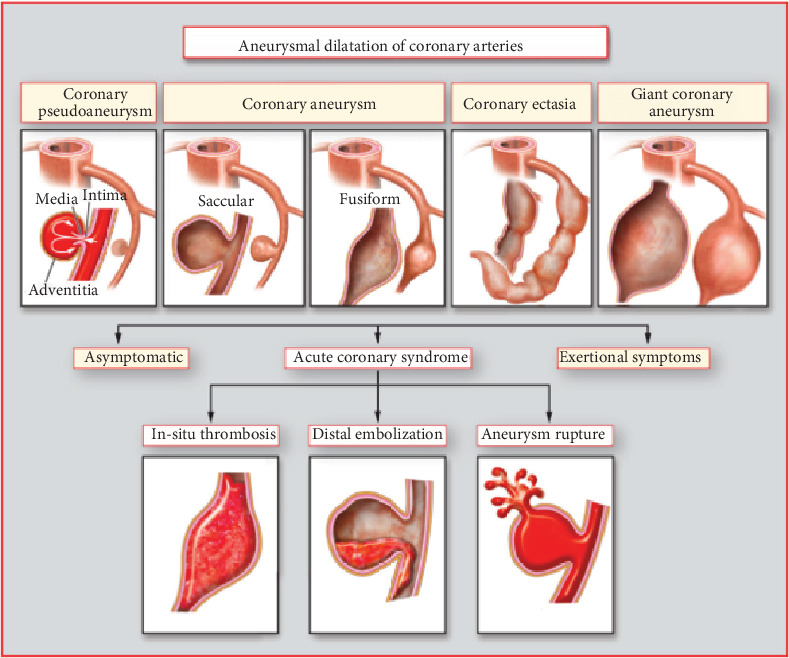
Morphologies of coronary artery aneurysms [2].